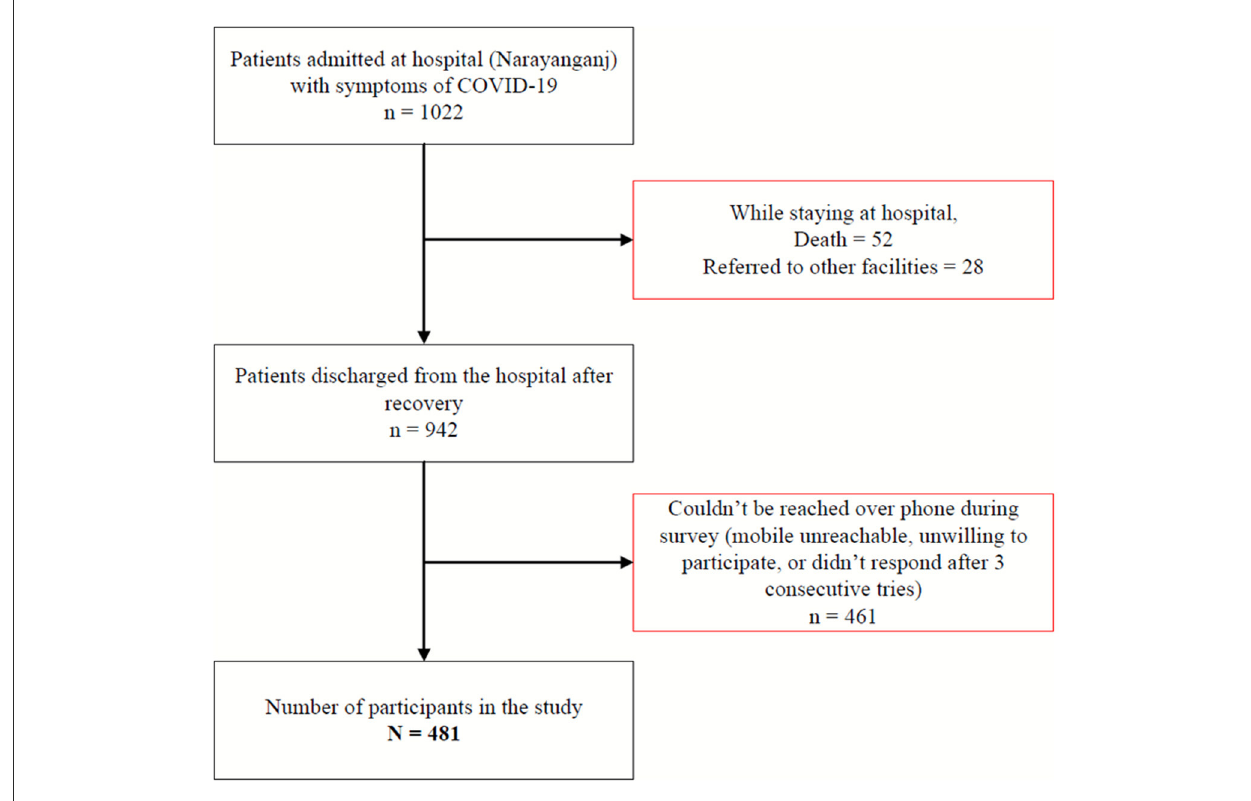
FIGURE1 Sampling and sample